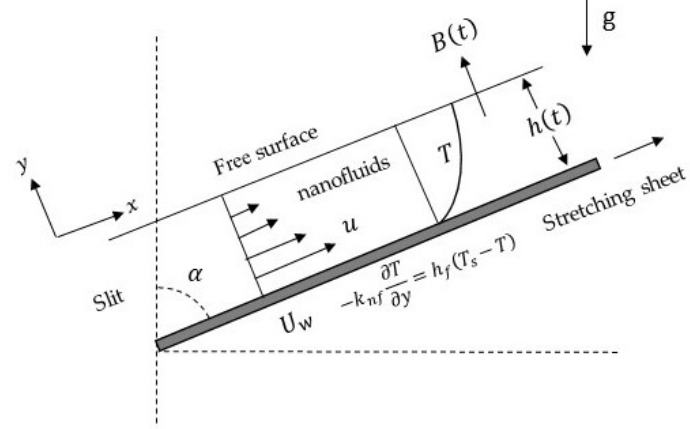
Figure 1. Schematic diagram of the present study.